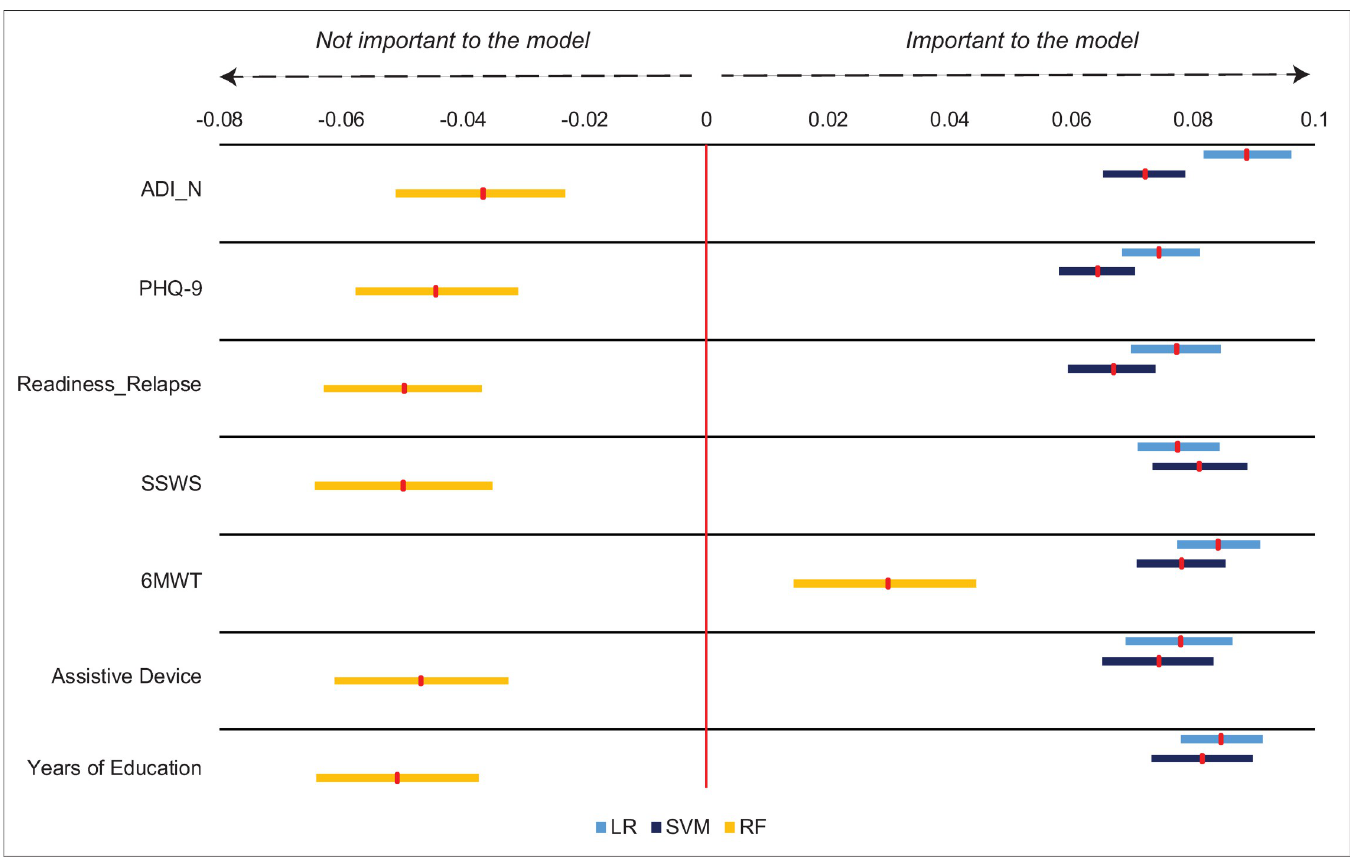
Fig 2. Drop column feature importance for home vs. community threshold (2500 steps/day). Red markers show mean feature importance with 95% bootstrapped confidence interval. 6MWT was the only feature found to be important across all three algorithms. Abbreviations: ADI_N- Area Deprivation Index (national percentile), PHQ-9- Patient Health Questionnaire-9, Readiness_Relapse- Readiness to change relapse score, SSWS- self-selected walking speed, 6MWT- 6-Minute Walk Test, LR- Logistic regression, SVM- Support vector machine, RF- Random forest.